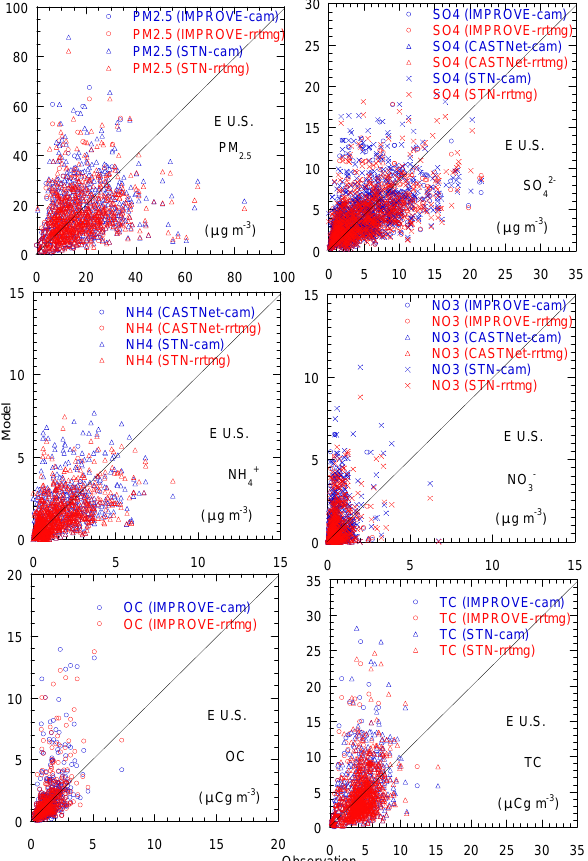
Observation Figure 6b. Comparison of observed and modeled (CAM(WRF-CMAQ/CAM) and RRTMG (WRF- Figure 6b. Comparison of observed and modeled CAM (WRF– CMAQ/RRTMG)) PM 2.5 and its chemical composition at the IMPROVE, CASTNet and STN sites over the CMAQ/CAM) and RRTMG (WRF–CMAQ/RRTMG) PM 2 . 5 and western U.S (longitude<100 0 ) its chemical composition at the IMPROVE, CASTNET and STN sites over the western US (longitude <100 ◦